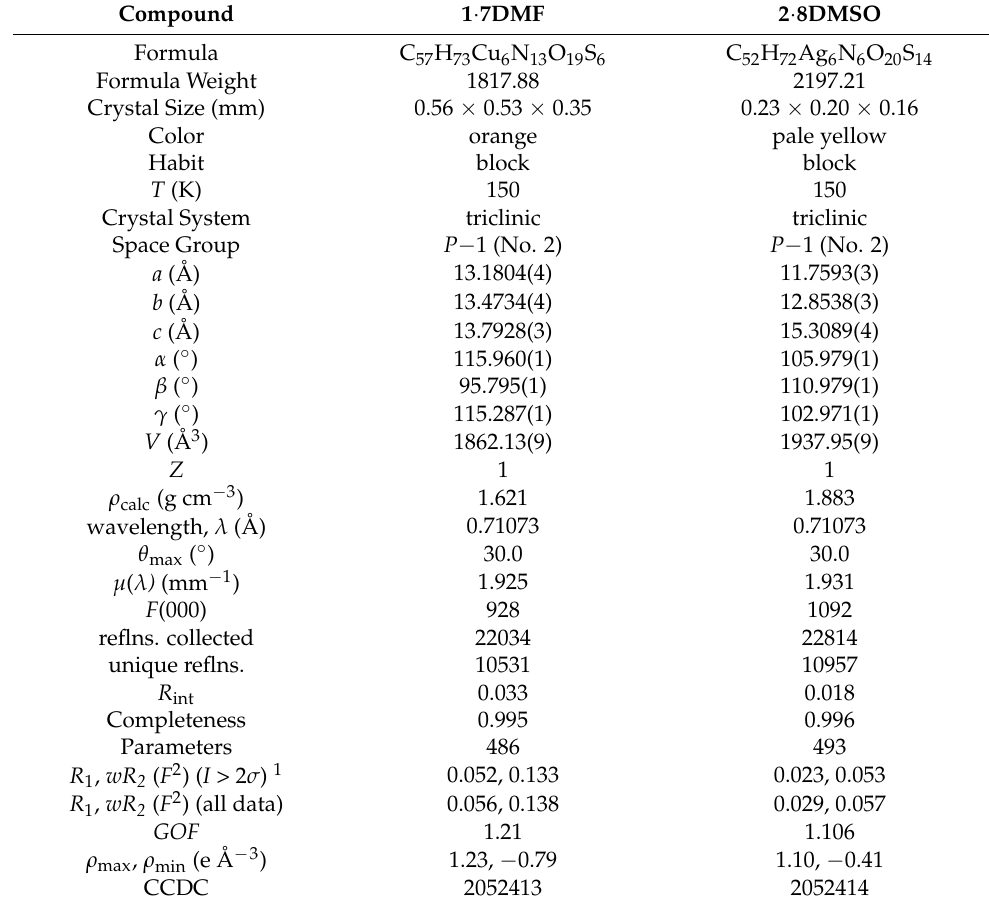
Table 1. Crystallographic and structure refinement data for 1 · 7DMF and 2 ·